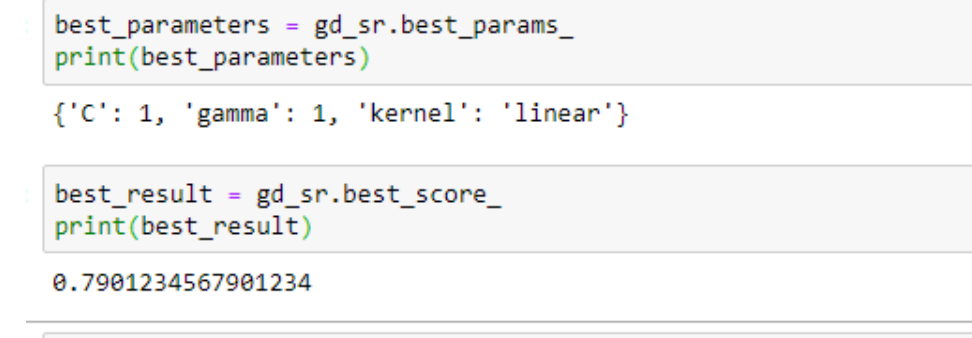
Figure 22. The best parameters with obtained after performing Grid Search with 5-Fold Cross-Validation on the SVM-Linear model. Table 6. Accuracies achieved by performing 10-Fold Cross-Validation on the SVM-Linear model.